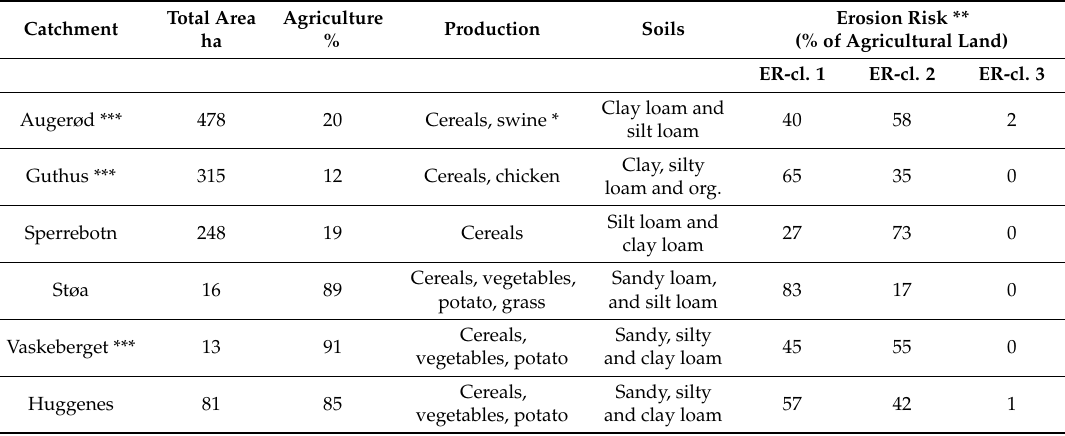
Figure 1. Location of the Vestre Vansjø catchment with the six case study catchments. Table 1. Total catchment area, percent agricultural area, production, soils and erosion risk (ER, % of agricultural land)